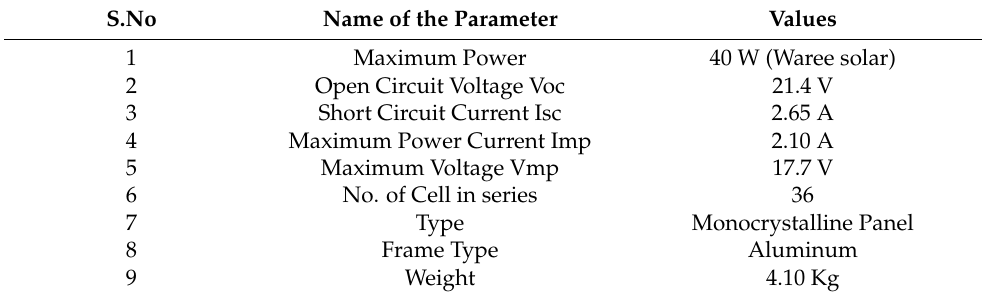
Table 1. Solar panel specification at 1000 W/M 2 and cell temperature 25 ◦ C. S.No